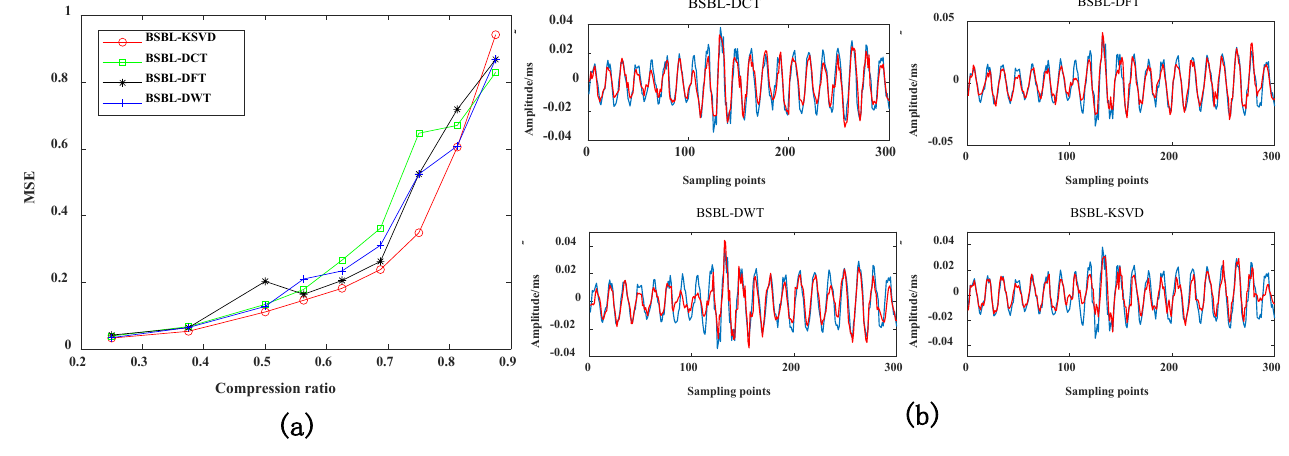
Figure 8. ( a ) Comparison of MSE indicators of different sparse dictionaries; ( b ) when CR = 0.5, the reconstruction signal comparison of different dictionaries.